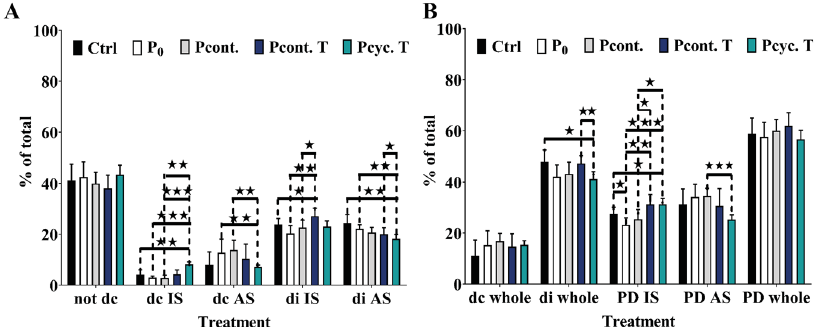
Fig. 2 Quantitative and qualitative determination of penetration depth (PD). A Depicts the quanti fi cation of PD measurements of the fi ve decellularization protocols. Measurements were taken for both the not decellularized area (not dc; innermost part of the aorta), and the decellularized area at the intimal side (dc IS) as well as adventitial side (dc AS). Moreover, PD measurements were also taken for disin- tegrated parts (intimal side = di IS and adventitial side = di AS) where